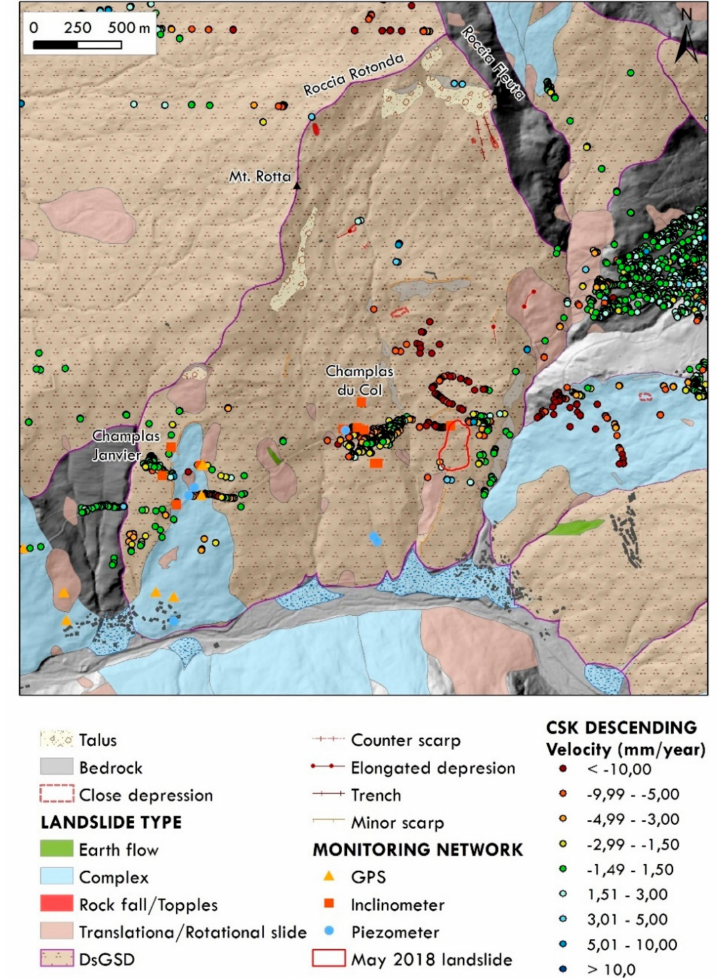
Figure 2. Geomorphological map of the Champlas du Col Deep-seated Gravitational Slope Deformation, landslides associated (landslide polygons source: SiFraP, Arpa Piemonte web-site [62]), in situ instruments (data source Arpa Piemonte web-site [62]) and remote sensing Cosmo-SkyMed (CSK) SAR data distribution (data source: Portale Cartografico Nazionale [63]); red polygon corresponds to the May 2018 reactivation and the purple one to the Champlas du Col